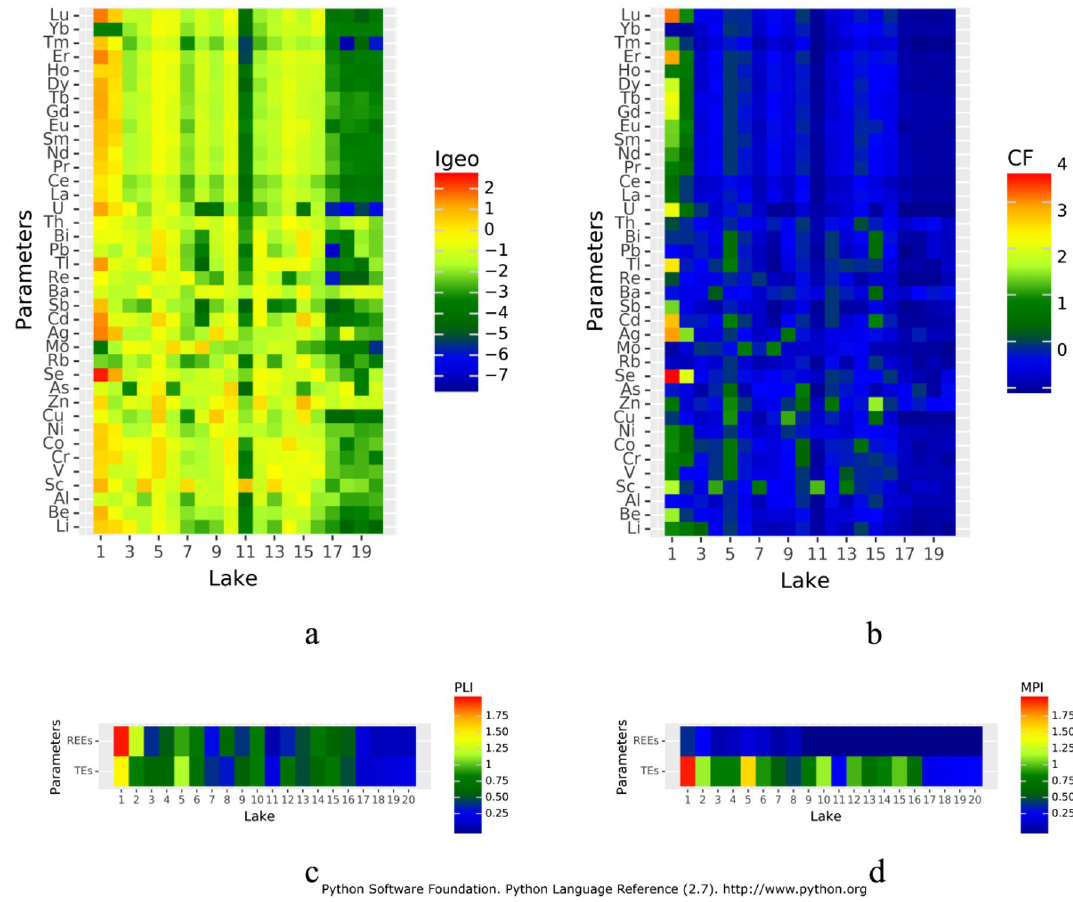
Figure 3. Contamination of lake bottom sediments calculated on the basis of Igeo ( a ), CF ( b ), PLI ( c ) and MPI ( d ) indices. Figure generated in Python Language Reference 2.7 (http://www.pytho